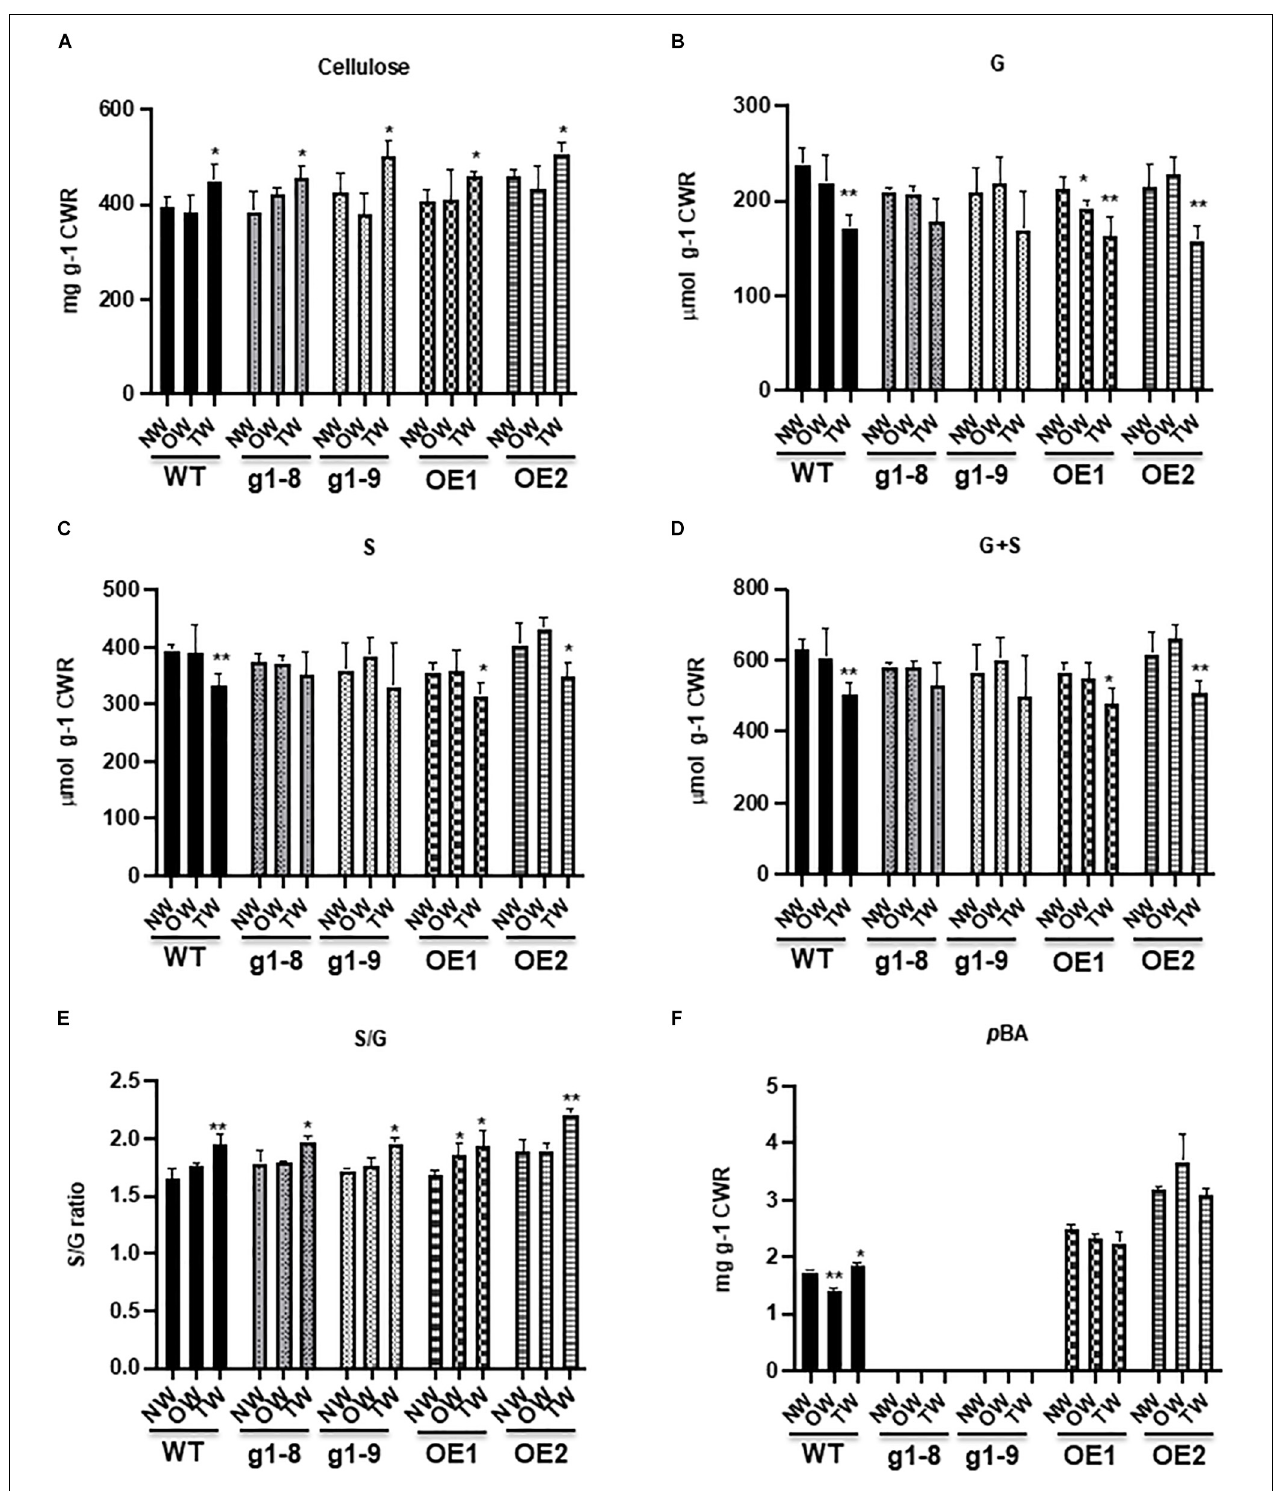
FIGURE 5 | Accumulation of crystalline cellulose, lignin, and wall-bound p -hydroxybenzoates in the WT, phbmt1 mutant, and OE lines of hybrid aspen. Content of crystalline cellulose (A) , thioacidolysis-cleaved G (B) and S (C) monomers, the total G + S monomers (D) , the S/G ratio (E) , and the alkaline-released wall-bound p -hydroxybenzoates (F) in NW, OW, and TW of the WT, phbmt1 knockout lines (g1-8 and g1-9), and OE lines (OE1 and OE2). CWR, cell wall residue. Data in (A–F) represent the mean ± SD of four biological repeats. Asterisk indicates significant difference compared with the corresponding normal wood, * P < 0.05, ** P < 0.01 (Student’s t